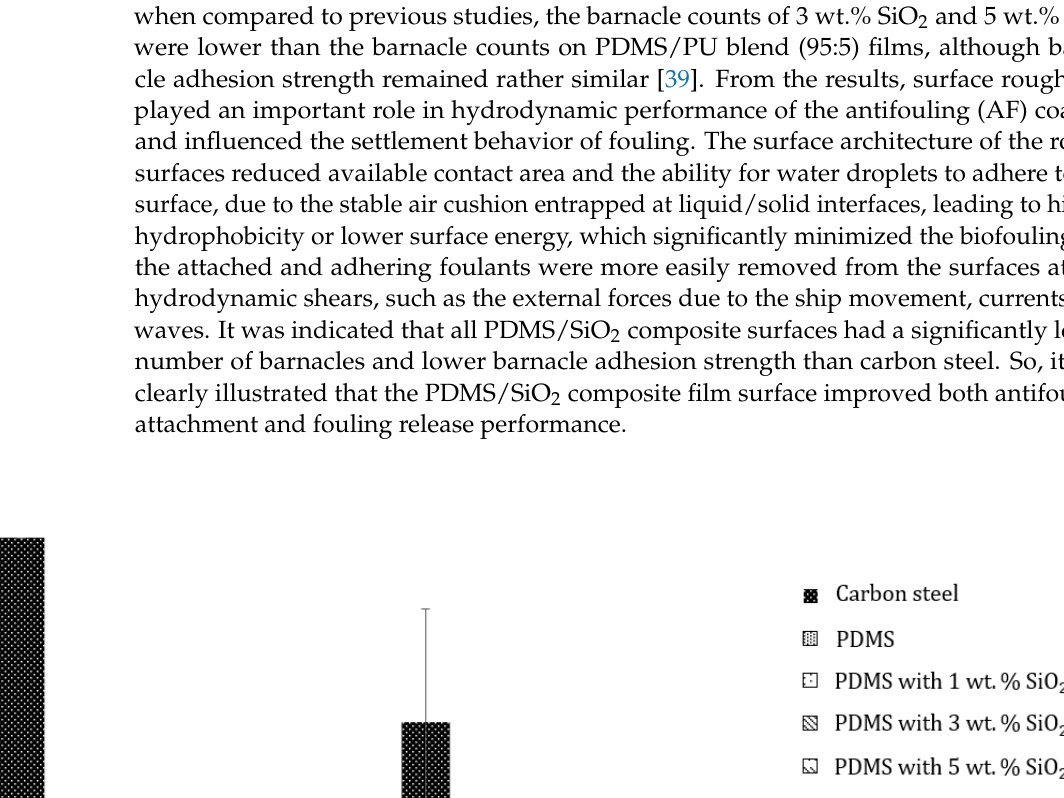
Figure 4. Marine biofouling on various sample surfaces after immersed in seawater environment (in April-June) ( a – h ) immersed for 2 weeks; ( i – p ) immersed for 4 weeks and ( q – z ) immersed for 8 weeks.